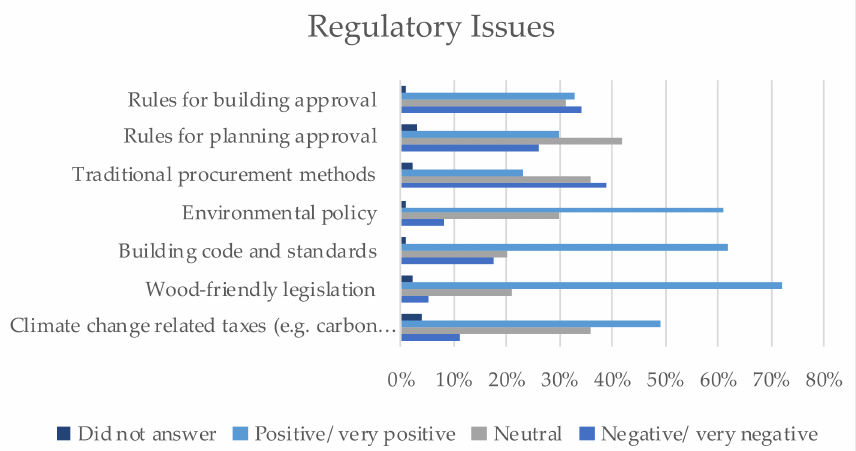
Figure 10. Responses to the question, ‘What impact do the following regulatory issues have on the adoption of timber in multi-storey projects in Australia?’.